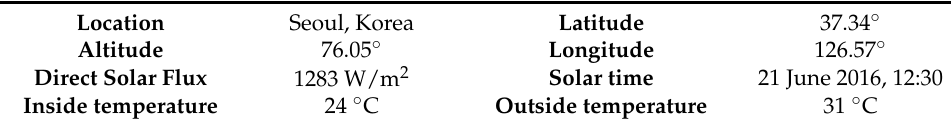
Figure 4. SDSW model for CFD. ( a ) External window; ( b ) Internal Window. Table 10. Solar model input data.